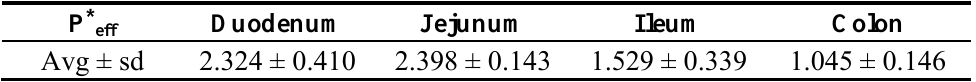
Table 1. Permeability of baohuoside I in different intestinal segements(mean ± SD, n = 4). P *